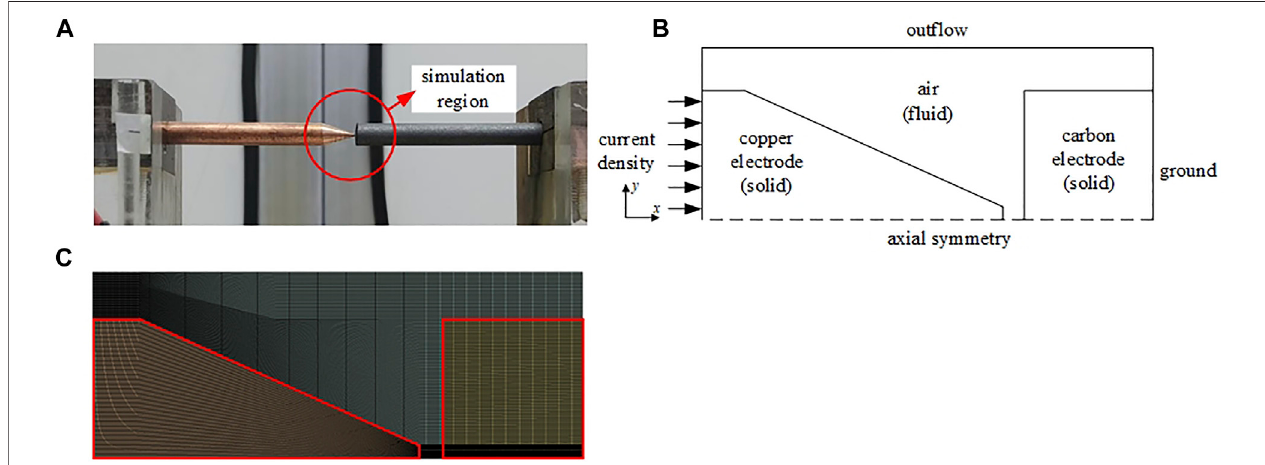
FIGURE 4 | Arc plasma MHD model. (A) Geometric model, (B) simulation model boundary, and (C) mesh of MHD